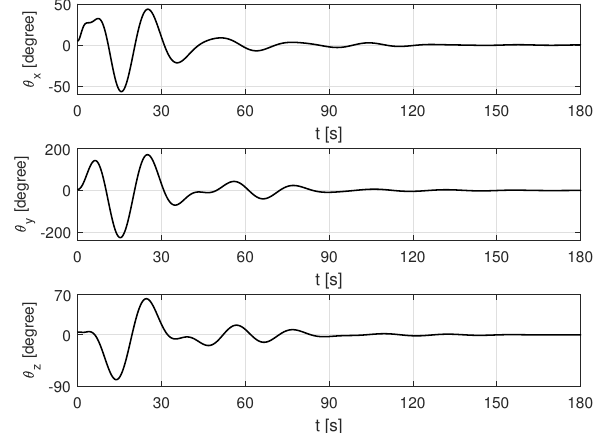
Figure 9. Angular position of the spacecraft.